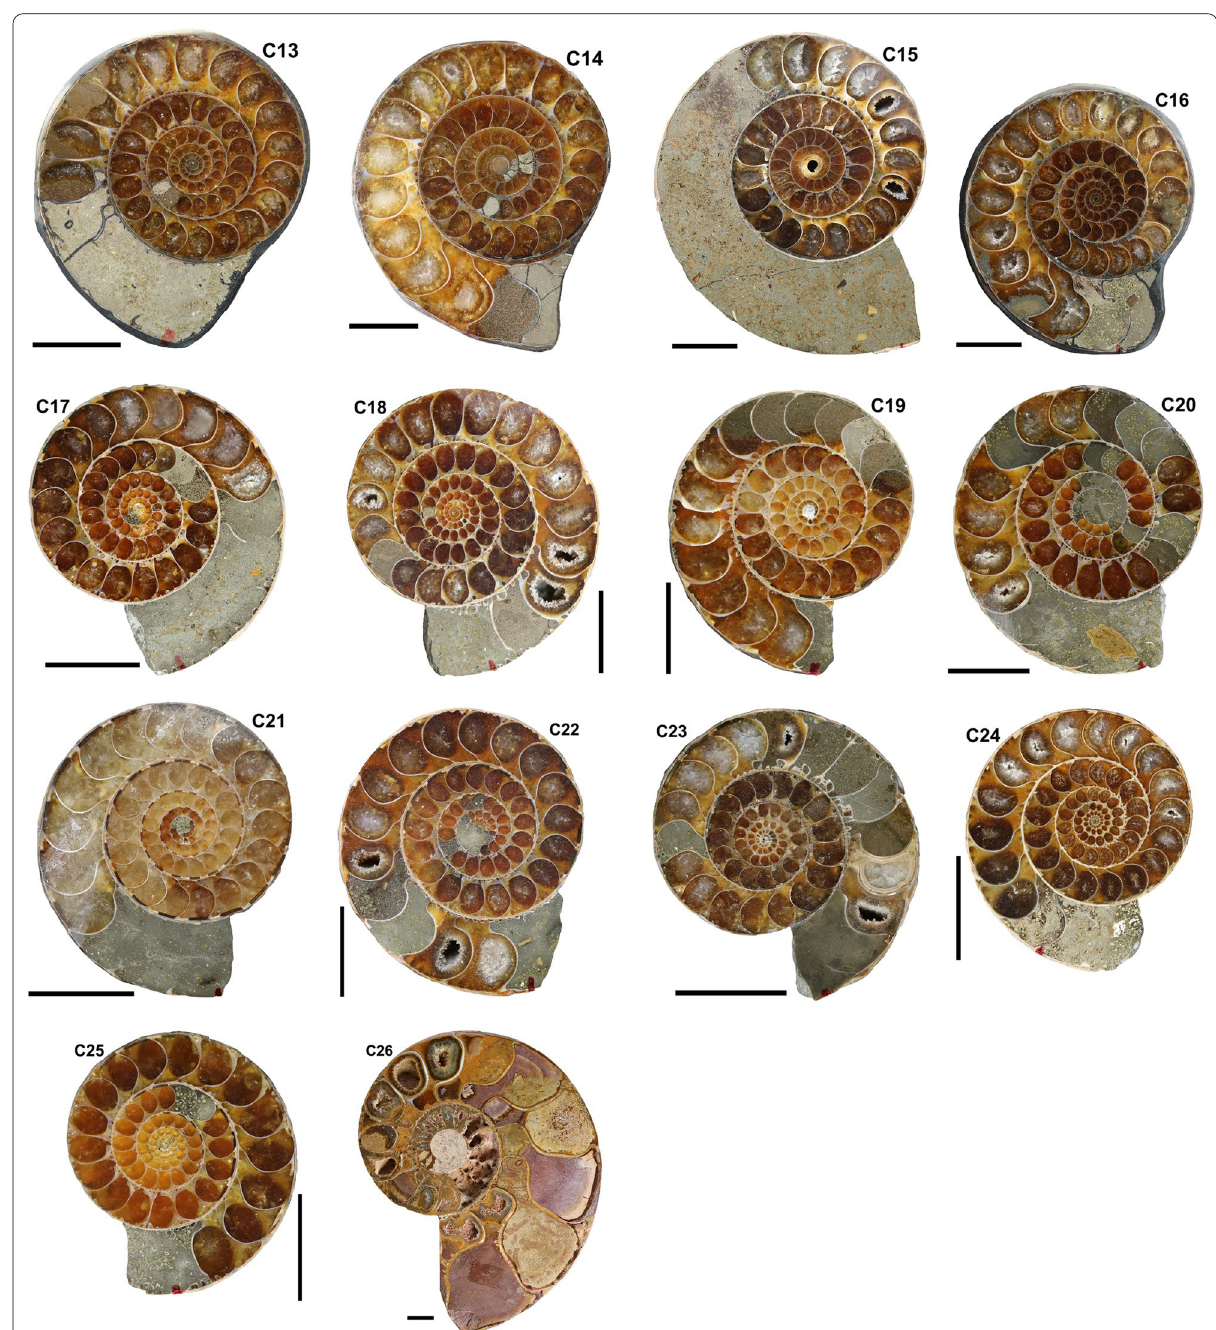
Fig. 5 Cretaceous ammonoids, Albian, Madagascar (for details see Table 1). (C13 to C25) Eogaudryceras umbilicostriatus (RUB-Pal 14101D), (C13) RUB-Pal 14101E, (C14) RUB-Pal 14101F, (C15) RUB-Pal 14101H, (C16) RUB-Pal 14101G, (C17) RUB-Pal 14101J, (C18) RUB-Pal 14101K, (C19)